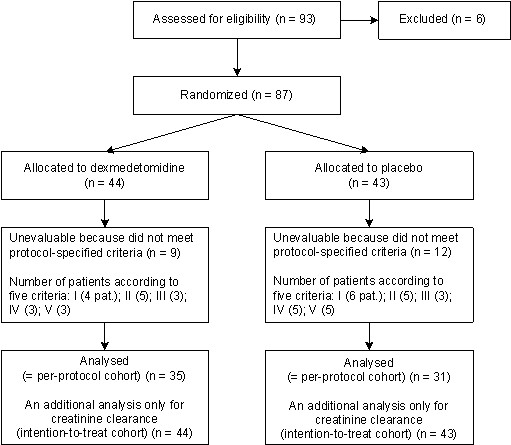
Summary of patient disposition.